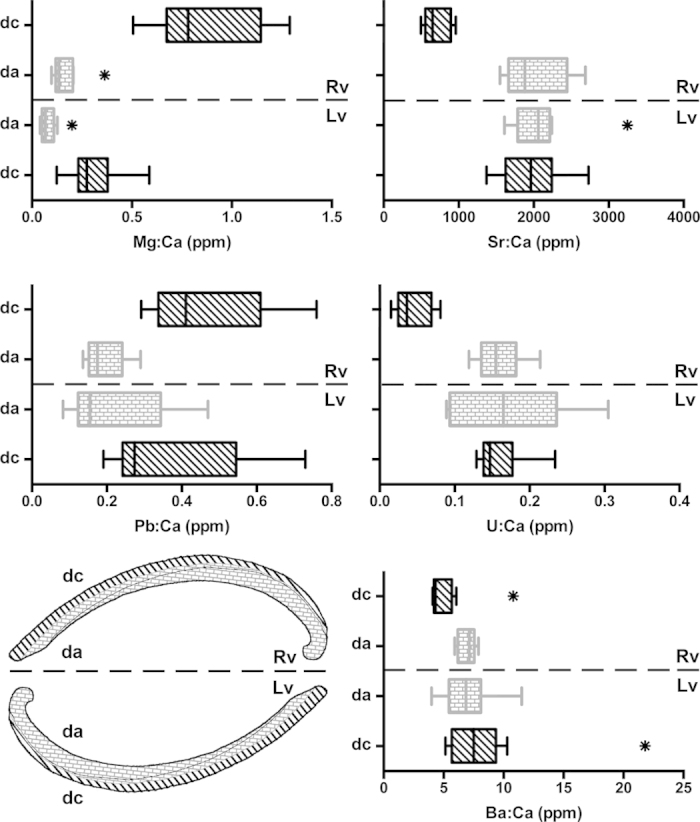
Element concentrations (X:Ca, parts per million) in calcitic (dc, black diagonal strikes) and aragonitic (da, grey brick pattern) layers of the dissoconch shell, on inversely mounted valves: Rv-calcite facing upwards, Lv-aragonite facing upwards.Bottom left: sketch showing the different shell layers in different shell orientations. Vertical lines: median value; boxes: interquartile range (IQR); whiskers: values <1.5 × IQR. Asterisks denote outliers (>1.5 × IQR).